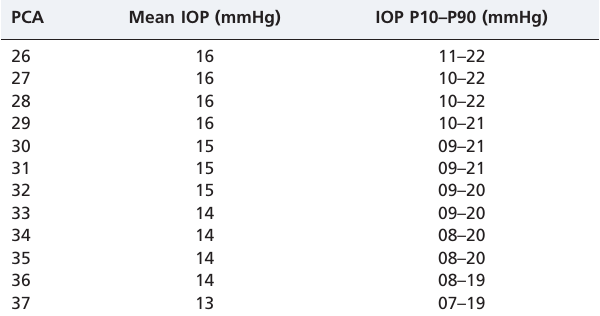
Table 2 - Intraocular pressure (P10–P90) according to postconceptional age.